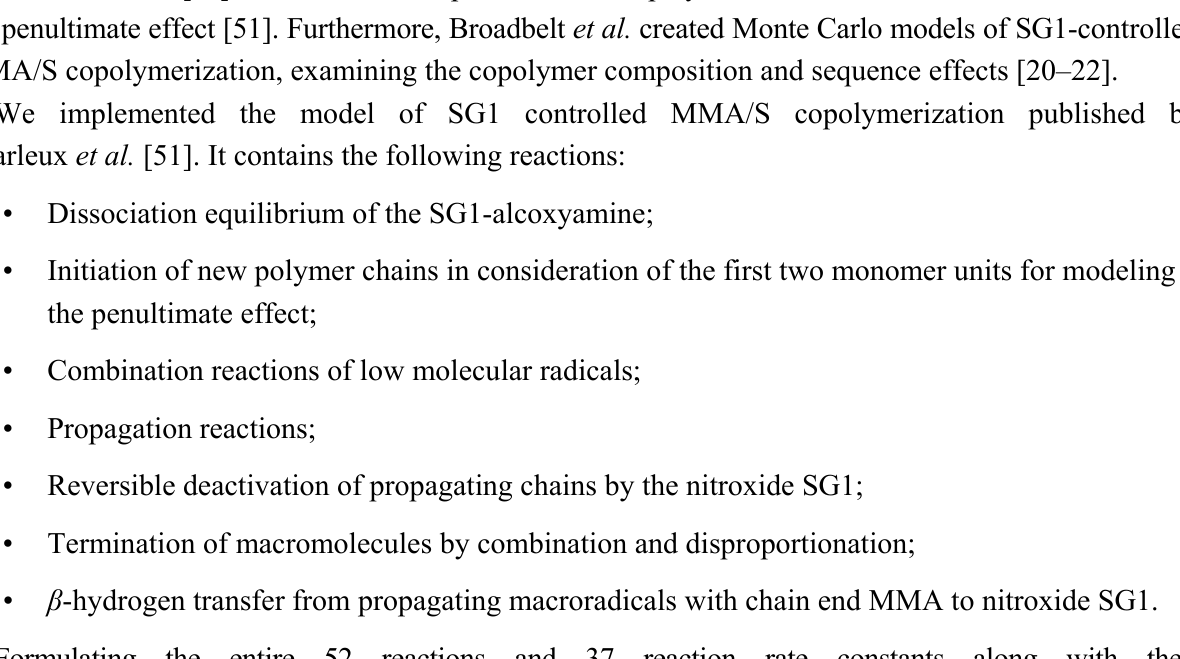
Figure 11. Persistence simulation time; 1: Update R